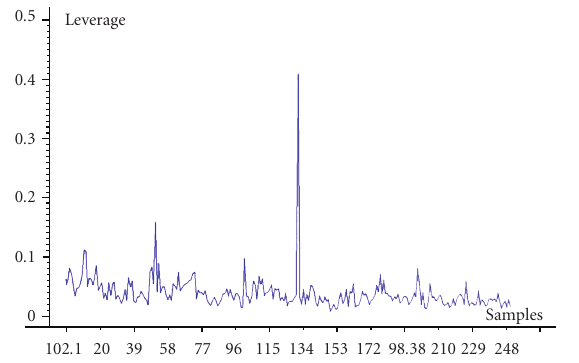
Figure 3: Sample leverage plot for calibration model.